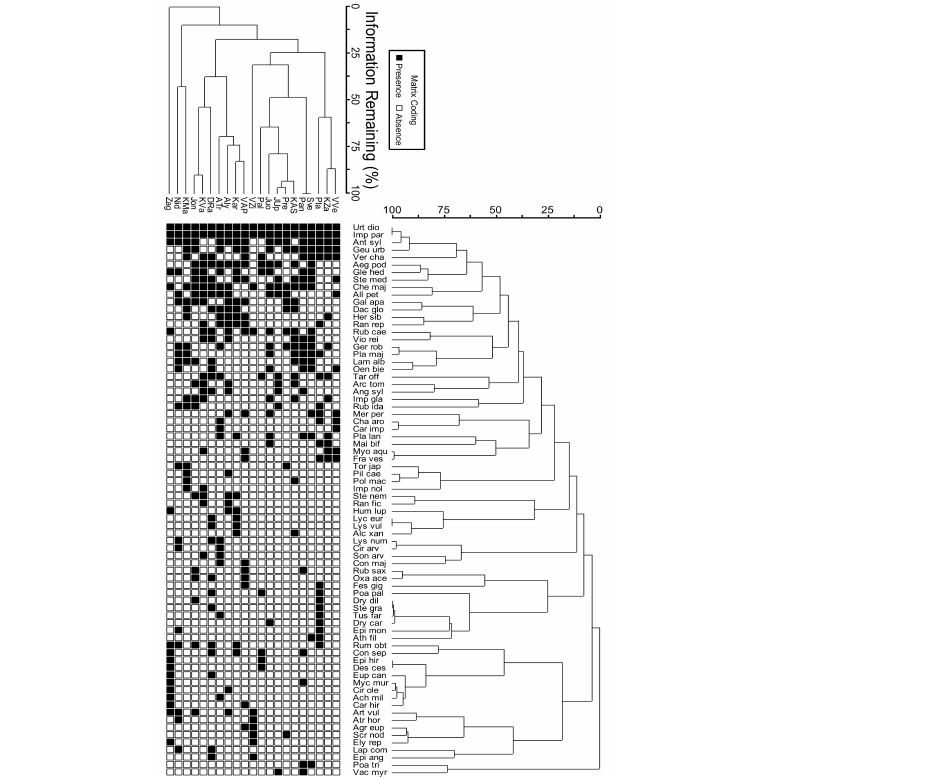
Figure 5. Clustering of the sites with small balsam ( Impatiens parviflora ) (top cladogram) and herba- ceous plant species in sites (right side cladogram). The number of herbaceous plant species—76 (NSp-76). In the right side cladogram: Urt dio— Urtica dioica L., Imp par— Impatiens parviflora DC., Ant syl— Anthriscus sylvestris (L.) Hoffm., Geu urb— Geum urbanum L., Ver cha— Veronica